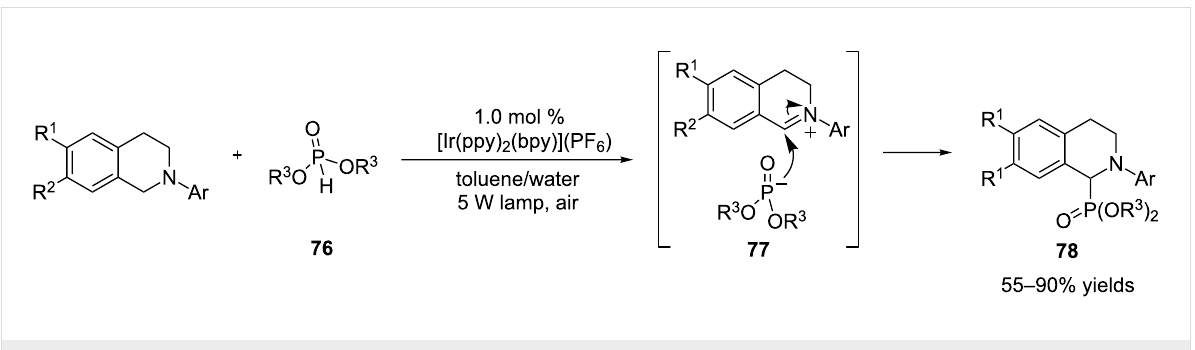
Scheme 20: Intermolecular interception of iminium ions by